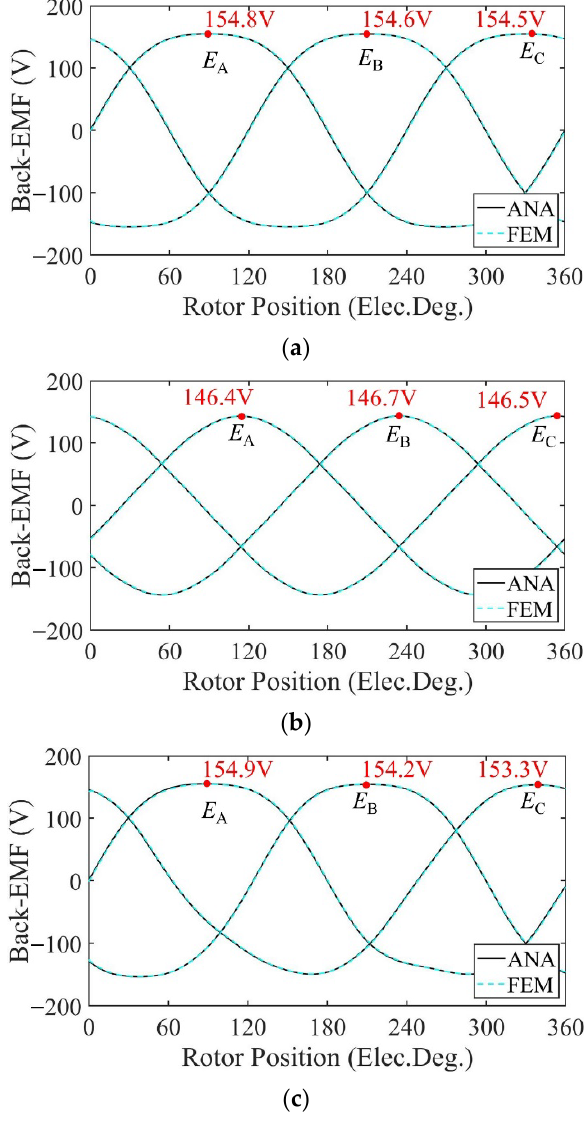
Figure 20. Back-EMF comparison. ( a ) Healthy; ( b ) uniform demagnetization; ( c ) partial demagnetization.